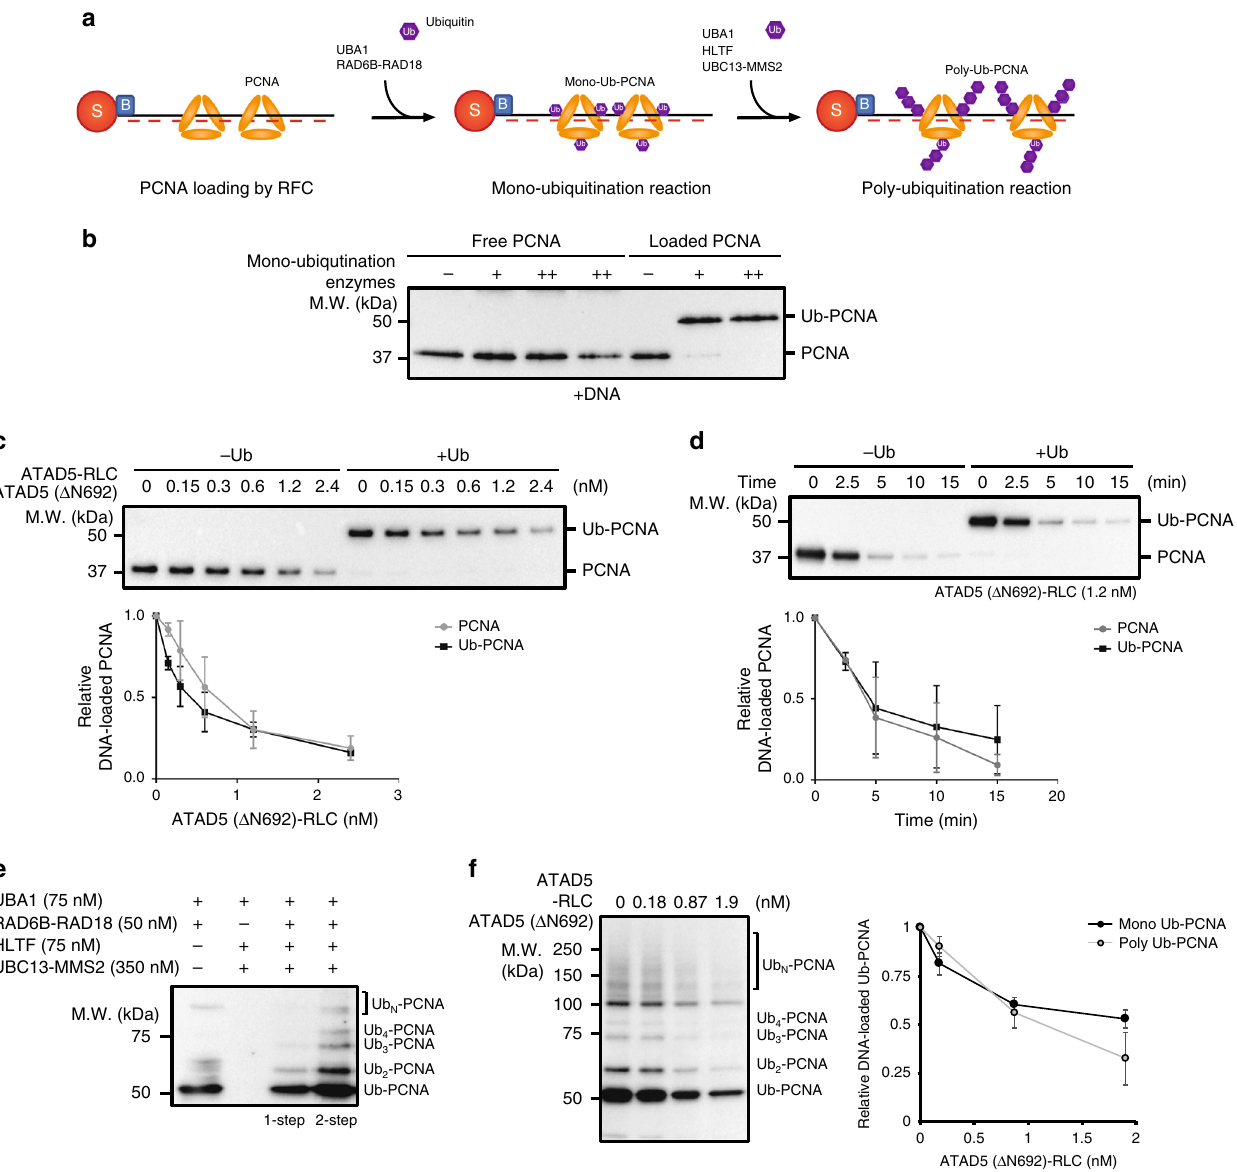
Fig. 5 ATAD5-RLC unloads ubiquitinated PCNA. a Schematic diagram of PCNA mono- and poly-ubiquitination. After loading onto bead-coupled DNA, PCNA was mono-ubiquitinated with UBA1, RAD6B-RAD18, and ubiquitin. Mono-ubiquitinated PCNA was poly-ubiquitinated with UBA1, HLTF, UBC13- MMS2, and ubiquitin. DNA beads were washed after each reaction to remove ubiquitination enzymes and free ubiquitin. Unloading of mono-ubiquitinated PCNA (Ub-PCNA) or poly-ubiquitinated PCNA (Ub N -PCNA) was monitored by immunoblot using anti-PCNA antibody unless indicated. b Mono- ubiquitination of PCNA. Same amount of free PCNA or DNA-loaded PCNA were ubiquitinated with mono-ubiquitination enzymes ( + : 16.7 nM UBA1, 66.7 nM RAD6B-RAD18, ++ : 33.4 nM UBA1, 133.4 nM RAD6B-RAD18). + DNA is a reaction in which free PCNA was mixed with bead-coupled DNA without loading reaction. DNA-loaded PCNA was preferentially mono-ubiquitinated. c – d ATAD5 ( Δ N692)-RLC unloads mono-ubiquitinated PCNA. The indicated amount of ATAD5 ( Δ N692)-RLC was used to treat DNA-loaded unmodi fi ed or mono-ubiquitinated PCNA. Graph shows relative PCNA or Ub-PCNA amounts remained on DNA after unloading reaction. In total, 1.4 kbps DNA was used for this assay. c ATAD5 ( Δ N692)-RLC were titrated in the unloading reaction of PCNA or mono-ubiquitinated PCNA ( n = 3). d Time-course unloading of PCNA or mono-ubiquitinated PCNA by 1.2 nM ATAD5 ( Δ N692)-RLC ( n = 2). e In vitro PCNA poly-ubiquitination. PCNA was loaded to 130-mer substrate DNA, then poly-ubiquitinated with the indicated enzymes. Poly- ubiquitination reaction was performed through a single step (1-step) or two steps (2-step). In two-step reactions, the poly-ubiquitination reaction was separately performed after the mono-ubiquitination reaction. The two-step reaction was more ef fi cient compared with the single-step reaction. f ATAD5 ( Δ N692)-RLC unloads mono- and poly-ubiquitinated PCNA with similar ef fi ciency. After the mono- or poly-ubiquitination reaction, ATAD5 ( Δ N692)-RLC was treated to DNA-loaded ubiquitinated PCNA. Unloading of ubiquitinated PCNA was monitored with anti-Ub-PCNA antibody. Graph shows relative mono-Ub-PCNA or poly-Ub-PCNA amounts remained on DNA after unloading reaction ( n = 3). See also Supplementary Fig.